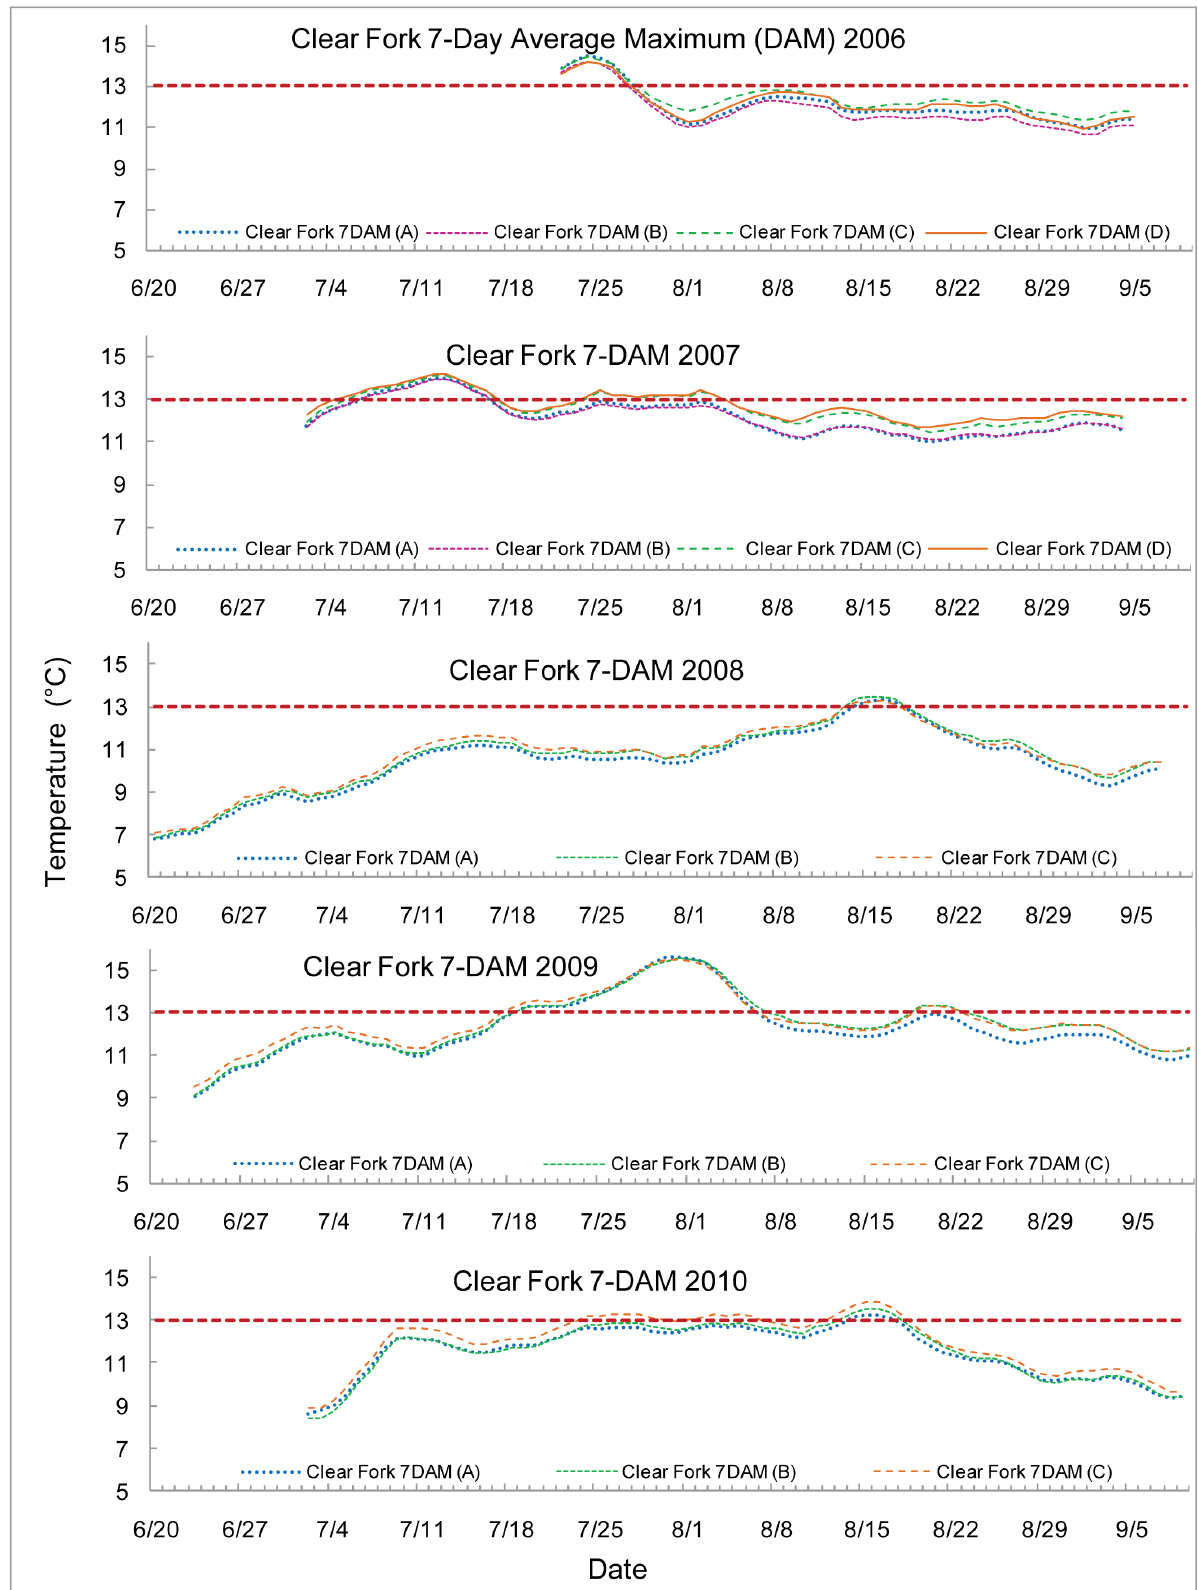
Figure 2. 7-Day average maximum (7-DAM) temperatures of Clear Fork.